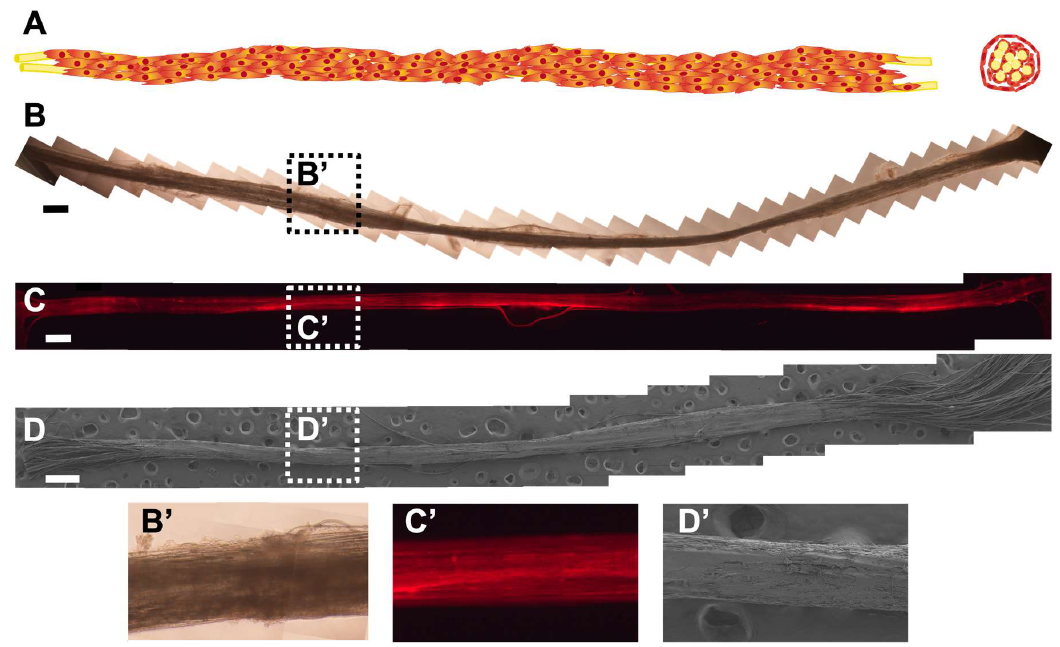
Figure 7. Schwann cells distribution in the ‘neural cord’ after 5 additional culture days. ( A ) Longitudi- nal and transversal schematic view of ‘neural cord’. ( B ) Representative phase-contrast reconstruction of the ‘neural cord’s’ complete length in culture before fixing. ( C ) Representative fluorescence re- construction of the ‘neural cord’s’ complete length after F-actin of SC staining with ActinRed™ 555 ReadyProbes™ Reagent (red). ( D ) Representative SEM reconstruction of the ‘neural cord’s’ complete length, showing a compact structure after the manipulation of the sample. Details in reconstructions are indicated with dash lines boxes in ( B’ ), ( C’ ), and ( D’ ). Scale bar: 500 µ m.